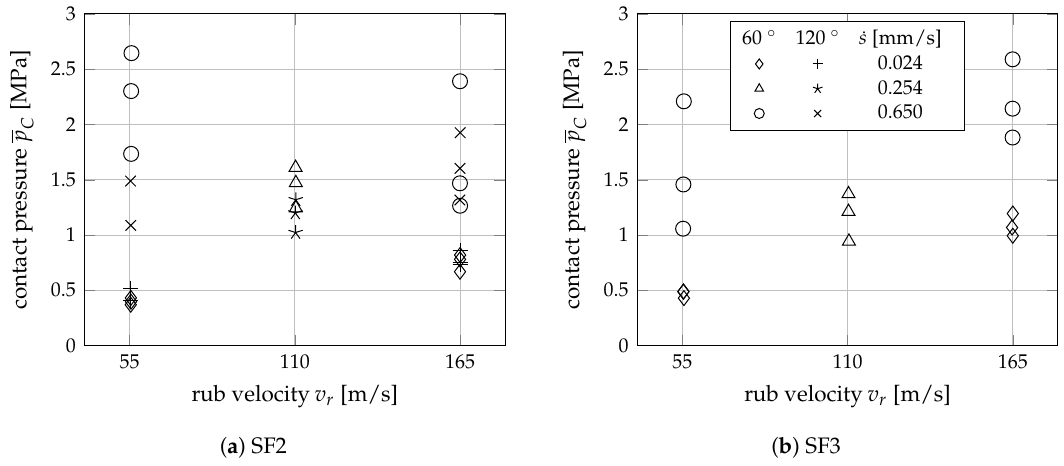
Figure 11. Average measured contact pressure for all five rub scenarios with sheet thickness 0.4mm.